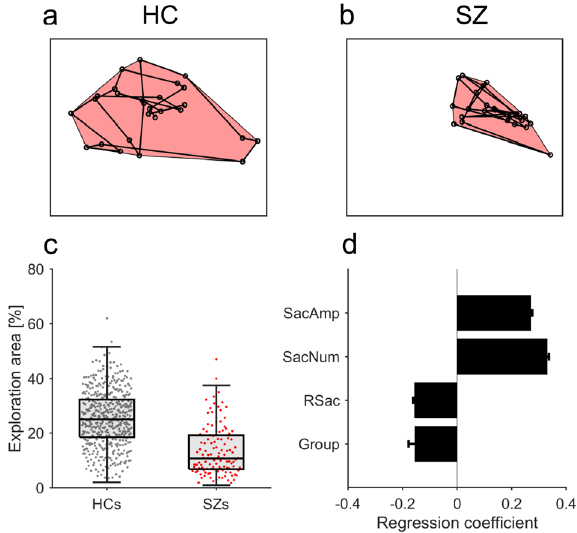
Figure 5. Contribution of return saccades to efficient visual search. ( a , b ) Regions explored by a representative HC ( a ) and SZ ( b ) are enclosed by connecting the outermost fixation locations (red shaded areas). The exploration area is defined as the proportion of the area enclosed by the outermost fixation locations relative to the entire image. ( c ) Box and beeswarm plots for the mean exploration area across images for HCs (N = 490) and SZs (N = 122). ( d ) Regression results of the GLME model to explain the exploration area based on saccade parameters. SacAmp saccade amplitude, SacNum total saccade number, RSac return saccade probability, Group HCs/SZs. Error bars indicate standard errors. All four parameters show significant effects ( p < 0.001).